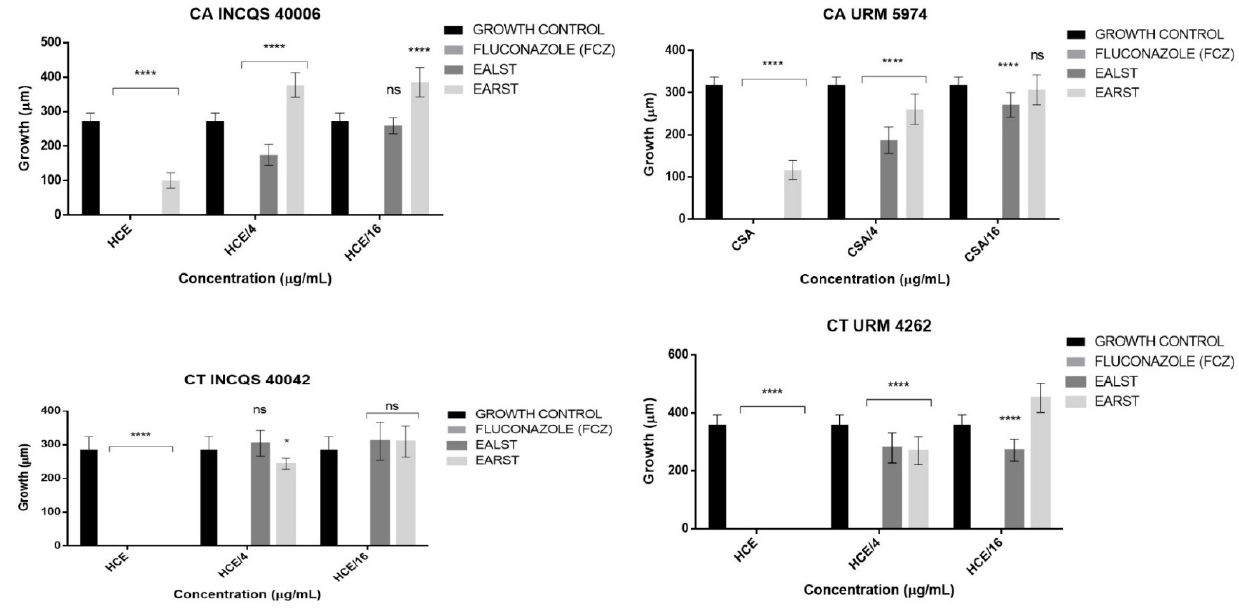
Figure 3. Effect of extracts and fluconazole on the morphological transition of Candida spp. CA: Candida albicans ; CT: Candida tropicalis ; INCQS: National Institute of Quality Control in Health; URM: University Recife Mycology; EALST: Extract Aqueous of Spondias tuberosa Leaves; EARST: Extract Aqueous of Spondias tuberosa Root; FCZ: Fluconazole; HCE: Higher Concentration Evaluated; ns: not significant; * p < 0.05; **** p < 0.0001—statistical significance.